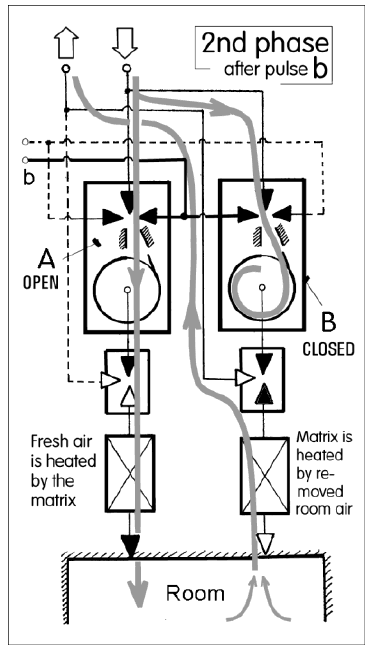
Fig. 23. Circuit diagram of an example of fluidic system recovering heat from the contaminated air [16] returned from the room and (at right) representation of the two air flows. Main components in this particular alternator are two bistable vortex valves Fig. 18.